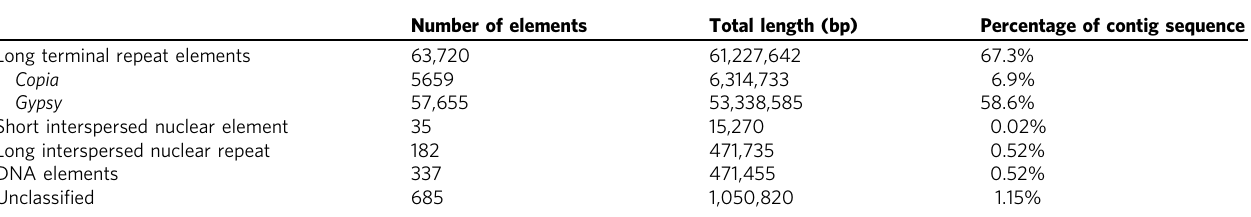
Table 1 Repeat statistics of the B . lactucae assembly Number of elements Total length (bp) Percentage of contig sequence Long terminal repeat